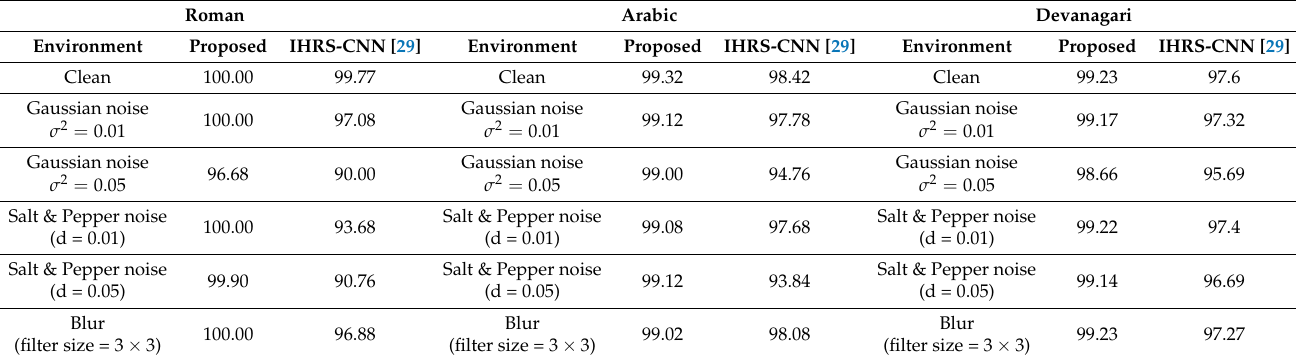
Table 6. Comparison between the proposed method and IHRS-CNN [29] method for Roman, Arabic, and Devanagari numeral recognition in both clean and noisy environments.